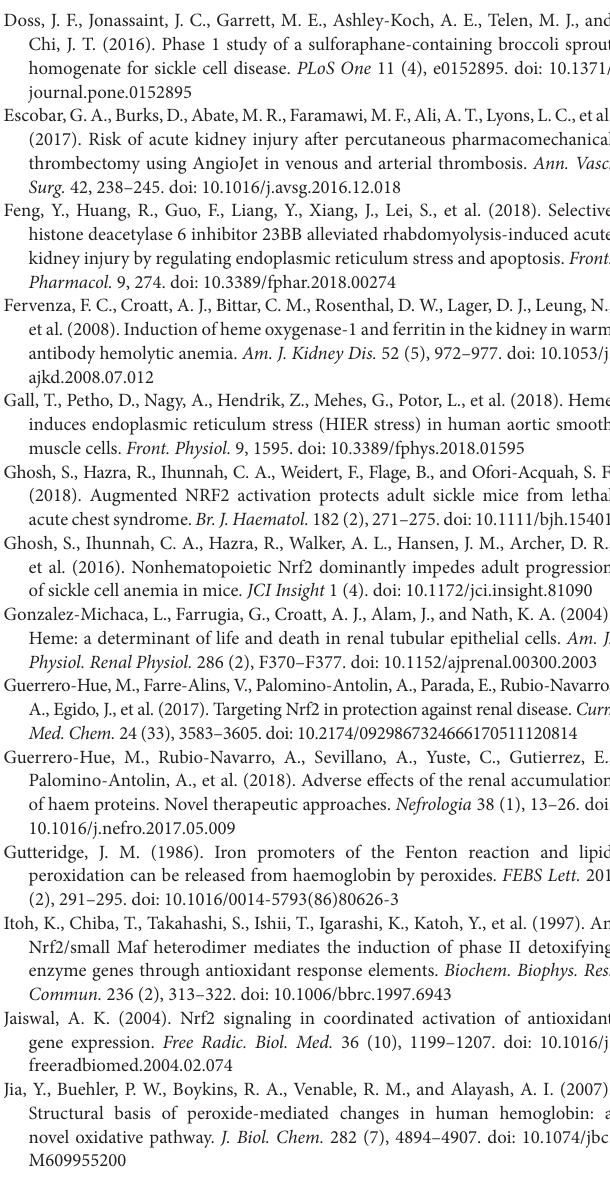
injury as there was no increase in the expression of these markers. (C) Quantification of total Nrf2 protein in kidney from control mice and treated with SFN (left panel). Representative western blot image showing total Nrf2 protein levels (right panel). Results are expressed as mean ± SE. *p<0.05 vs non-treated cells. FIGURE S3 | (A) Expression of FtH mRNA expression measured by RT-qPCR in MCTs cells treated with heme for 6h. (B) Western blot image showing FtH expression in MCT cells treated with Heme (0-10 µM) for 24h. (C) FtH protein expression in MCT cells stimulated with Hb (0-500 µg/mL, 0-30 µM heme equivalents). FtH mRNA expression measured by RT-qPCR (D) and semiquantification of FtH protein expression determined by western-blot (E) of kidneys from wild type and Nrf2 -/- mice injected with phenylhydrazine or vehicle. FtH mRNA expression measured by RT-qPCR (F) and semiquantification of FtH protein expression determined by western- blot (G) of kidneys from wild type pre-treated with SFN and injected with phenylhydrazine or